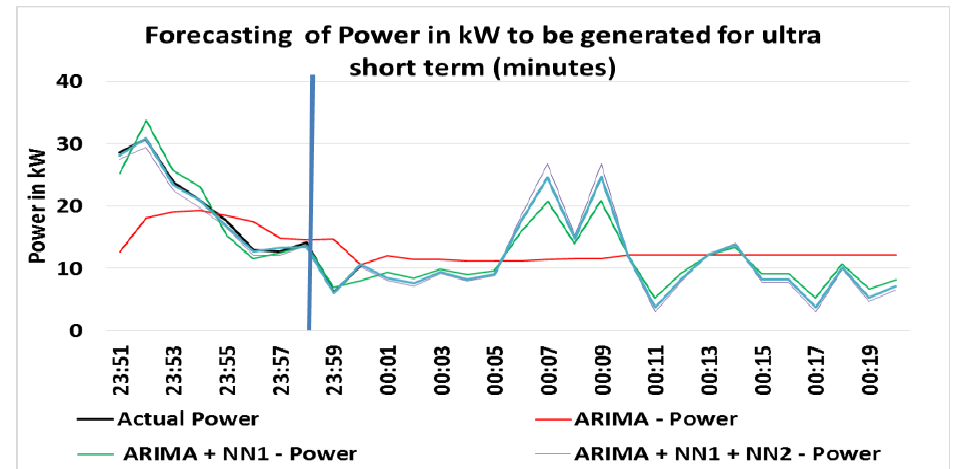
Figure 9. Generated power expected for ultra-short term (minutes) in KW.